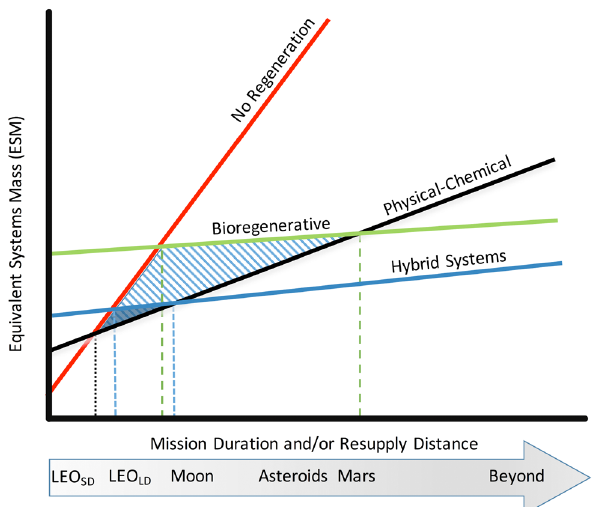
Figure 1: Cost comparison relative to mission duration and distance from Earth, in terms of equivalent systems mass, for four life-support